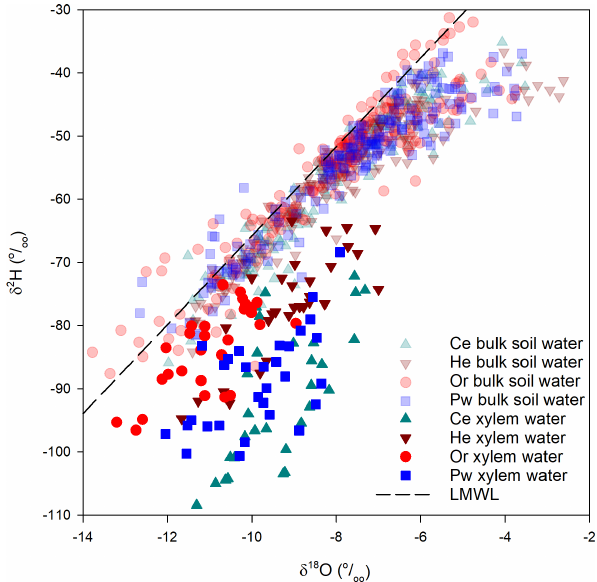
Figure A2. Isotopic composition of xylem water and bulk soil water (sampled at 5cm intervals from the soil surface) for the sampled tree species. Ce – eastern white cedar, He – eastern hemlock, Or – red oak, Pw – eastern white pine, LMWL – local meteoric water